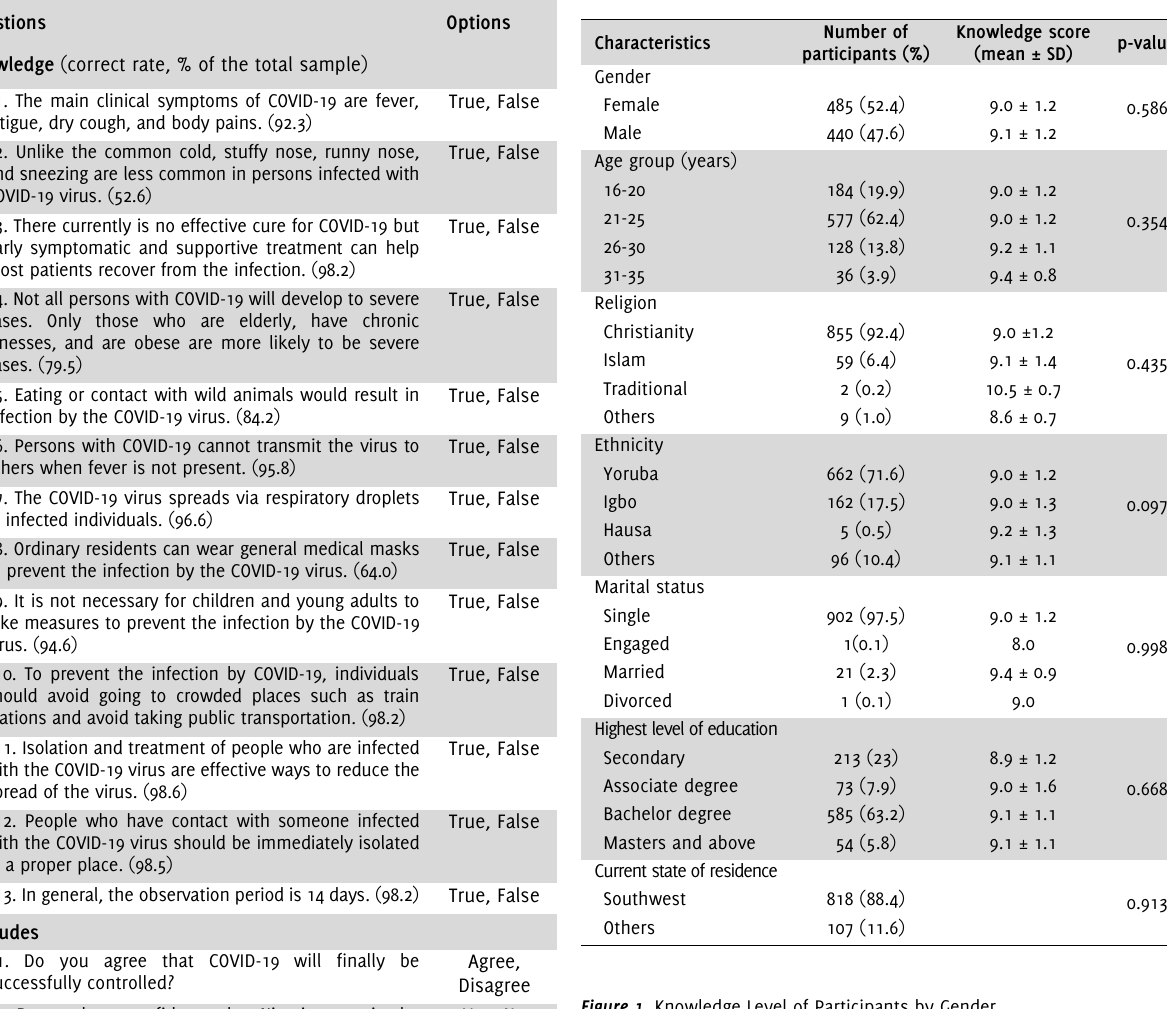
Figure 1 . Knowledge Level of Participants by